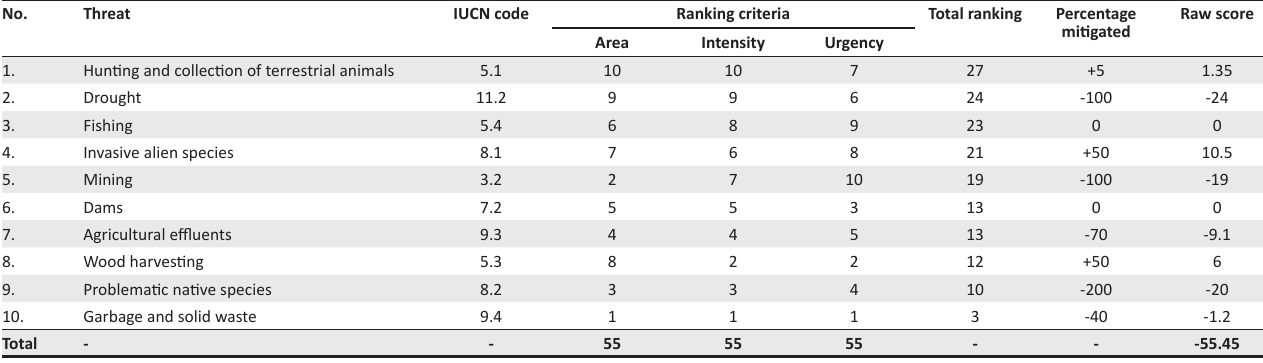
TABLE 1-A1: Modified threat reduction assessment index for the Letaba Ranch Nature Reserve.